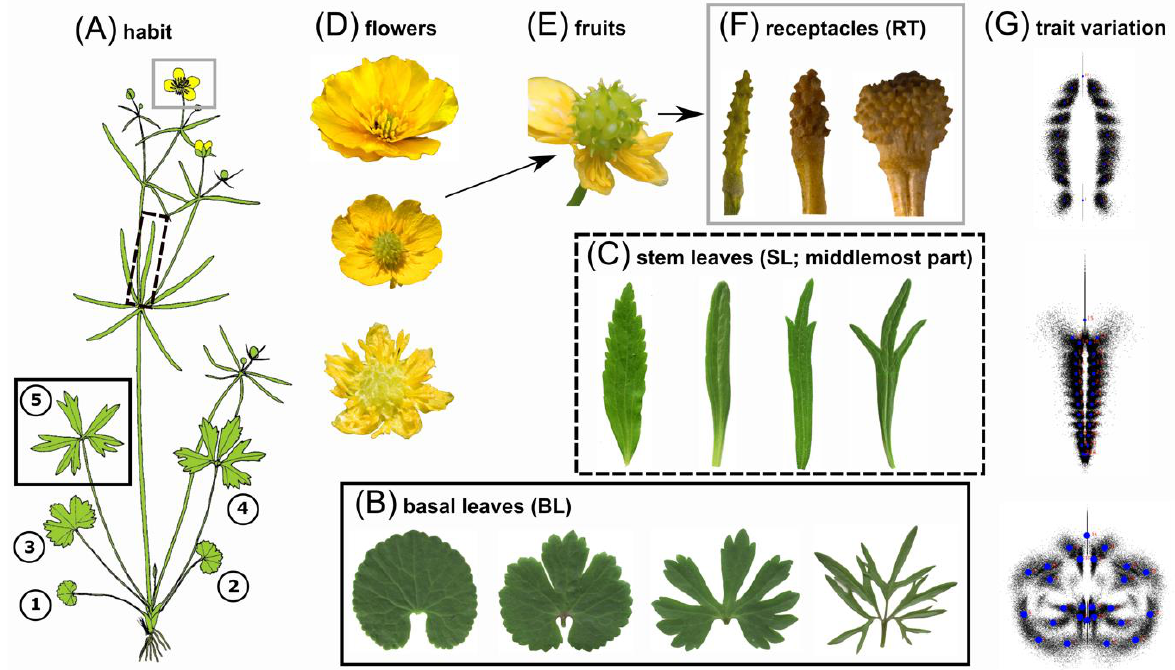
Figure 1. Morphological variation of taxonomically informative traits within the R. auricomus species complex (see also Figure S1A–C for leaf venation and landmark configurations per trait). ( A ) Illustration of a typical R. auricomus individual with morphological traits highlighted in boxes: basal leaf cycle (black box; 1–5, 1–4 = early spring leaves, 5 = most dissected leaf at anthesis) and stem leaves with the middlemost segment (black-dotted box) and reproductive structures (grey box; flower, fruit, and receptacle at the fruiting stage). Figure source: The figure was taken from [50], which is published under the Creative Commons Attribution License ( B ) Variability of basal leaves among taxa ranging from undivided (left) to broad three-lobed or dissected (center) to strongly dissected forms (right). ( C ) Variability of the middlemost segment of a stem leaf among taxa, ranging from broadly lanceolate (with teeth; left) to narrowly linear forms (with dissection; right). ( D ) Variability of petal variation, ranging from five to 15 (mostly sexuals; the uppermost flower) or reduced or absent forms (mostly polyploid apomicts; the lowermost flower). ( E ) Collective fruit in the ripening process: Concerning polyploid apomicts, a single collective fruit can contain achenes with either sexually or apomictically produced seeds. ( F ) Variability of receptacles among taxa, ranging from narrowly large (left) to smaller roundish receptacles (right). ( G ) The variation of the evaluated traits captured by GM is shown as clouds of 2D landmarks. Photographs of Figure 1B – F: © Kevin Karbstein.